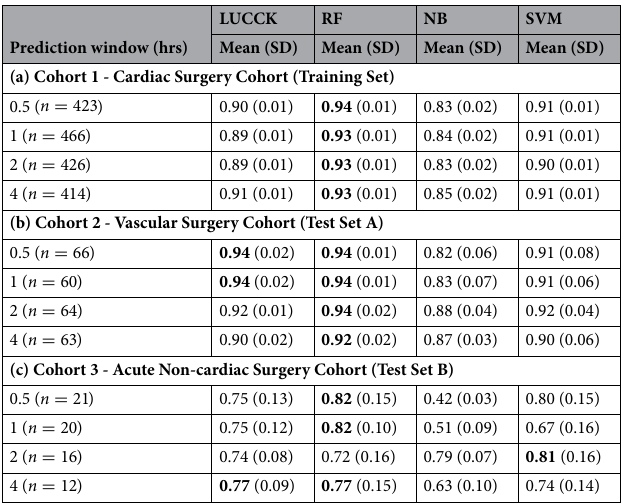
(c) Cohort 3 - Acute Non-cardiac Surgery Cohort (Test Set